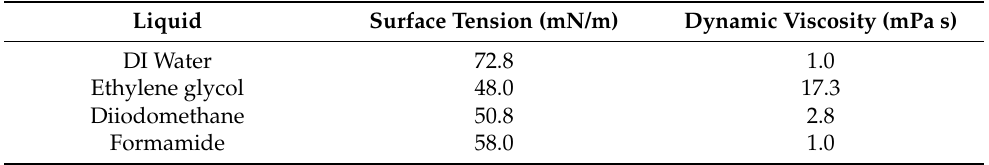
Table 3. Surface tension and viscosity of liquids employed in this work.